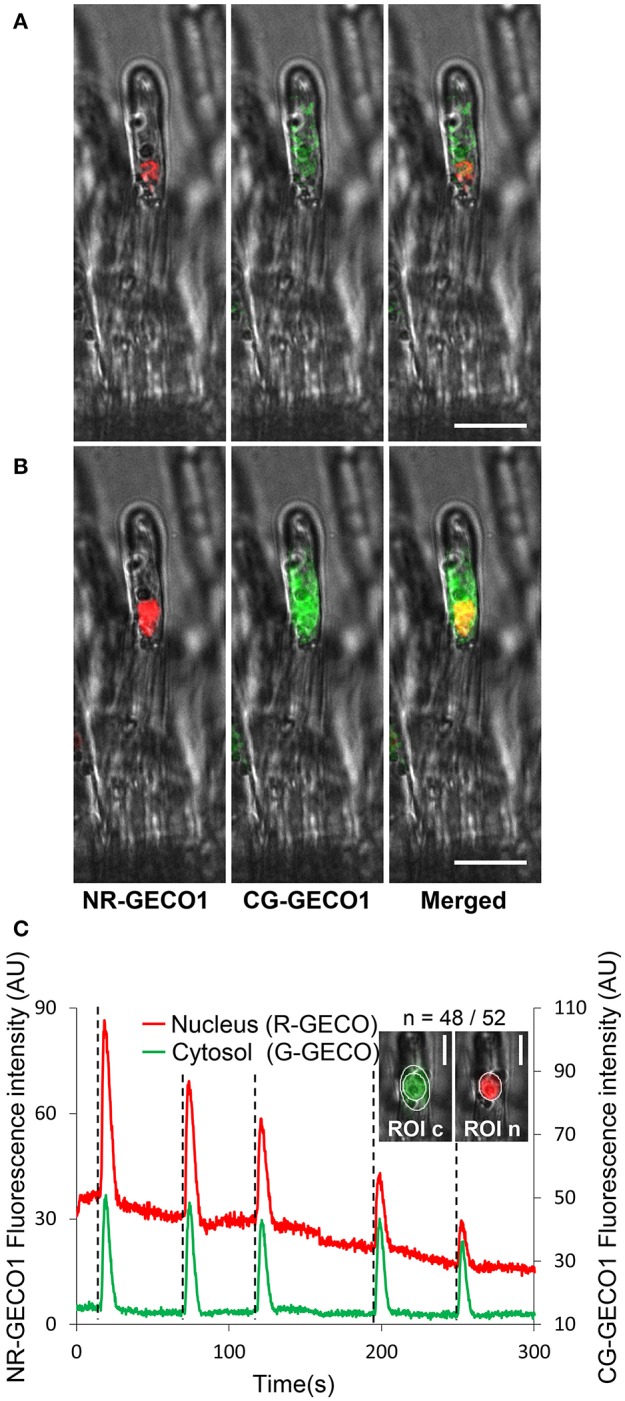
A dual GECO Ca2+ sensor targeted to both nuclear and cytoplasmic subcellular compartments reveals coordinated oscillatory Ca2+ responses. (A,B) Subcellular localization of the dual NRCG-GECO1 sensor in M. truncatula root hair cells. Confocal fluorescent images of NRCG-GECO1 sensor before (A) and during a spike (B) are represented as separated red, green, and merged images with respective bright fields. (C) Relative fluorescence intensity traces of NR-GECO1 (red) and CG-GECO1 (green) at 0.25 s intervals from ROIs selected around the nuclear (ROI n) and peri-nuclear cytoplasmic (ROI c) regions of a M. truncatula root hair treated with a 10−9 M Nod Factor (+NF) solution. Dotted lines mark the initiation of a spike, n corresponds to the number of root hairs responding positively/total number of analyzed root hairs. Data were collected from two biological experiments. Scale bars represent 20 μm (A,B) and 10 μm (C).